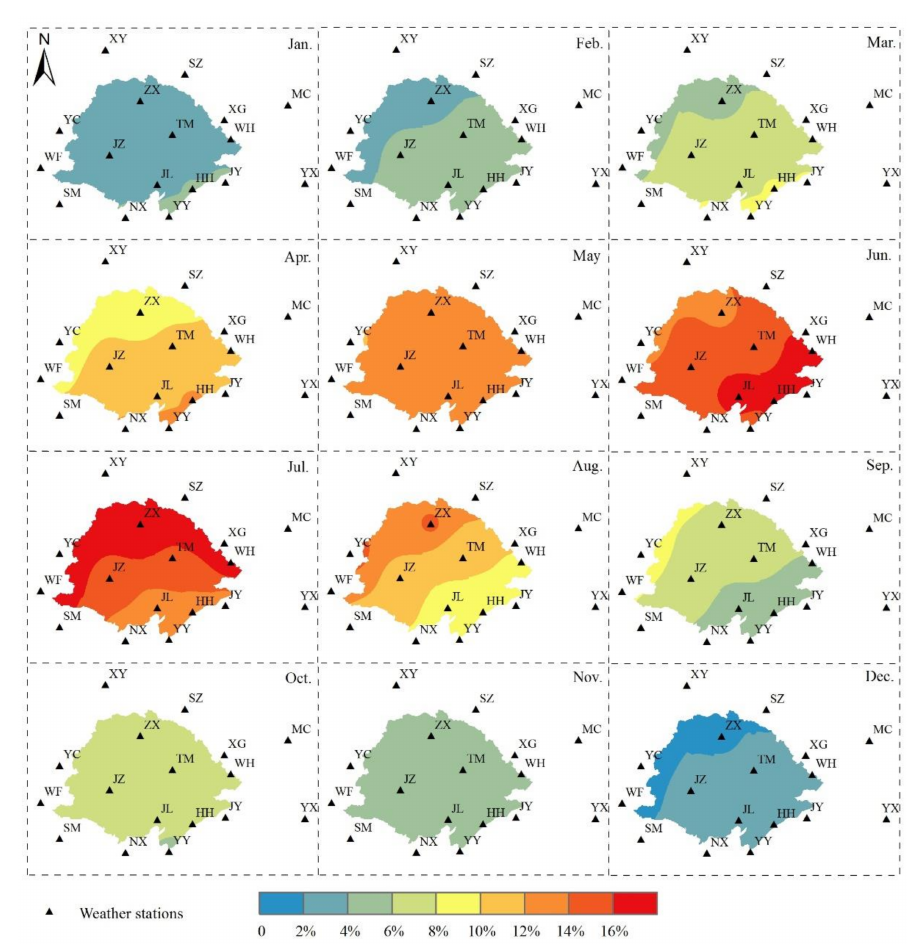
Figure A2. Spatial distributions of mean monthly precipitation in JHP from 1977 to